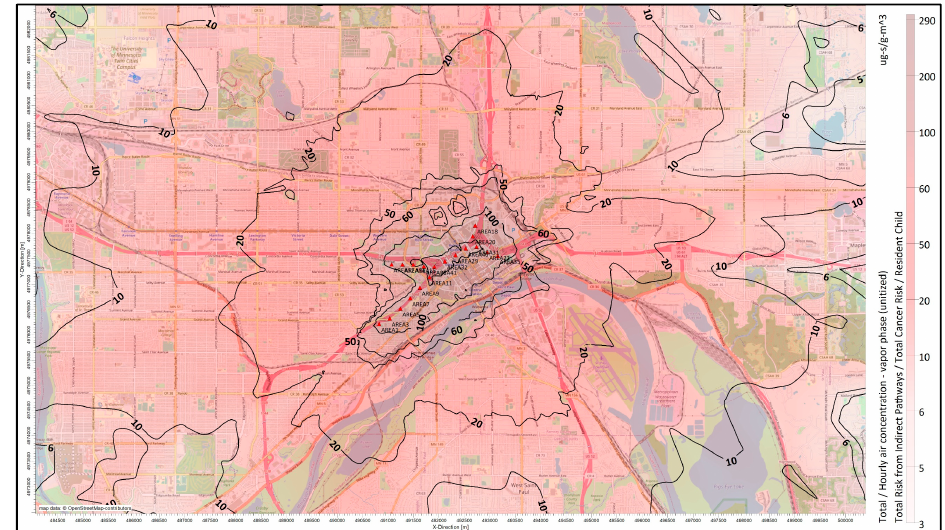
Figure 5. Benzene Hourly Air Concentration—Vapor Phase (Unitized) Contour Plot overlaid on OpenStreetMap Satellite Imagery (OpenStreetMap, n.d.). Unit used in contour is µg-s/g-m 3 .